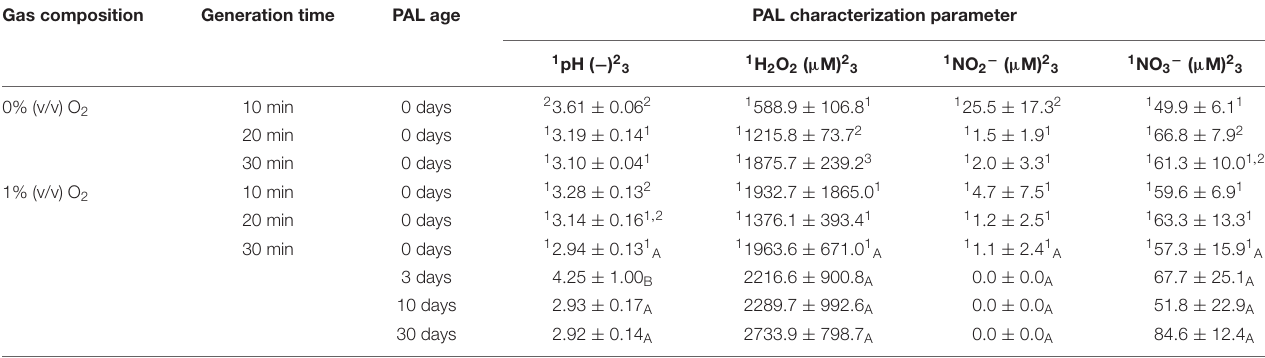
TABLE 1 | Characterization of plasma activated liquids.